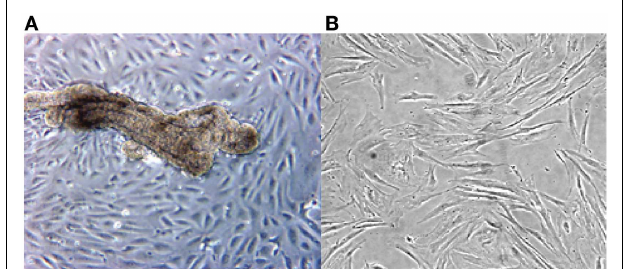
FIGURE 1 | Phase contrast microscopy of a primary culture of a fragment from ovarian endometrioma (A) . Note presence of an endometriotic gland giving rise to a monolayer of epithelial-like cells (A) . In (B) , aspect of elongated fibroblast-like cultured cells obtained from the stromal component of a large peritoneal endometriotic implant (B) .